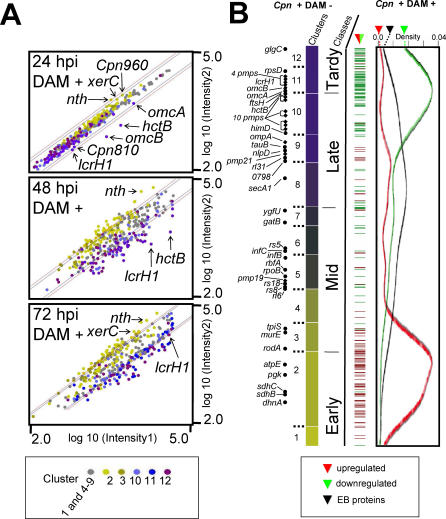
Comparison of Cpn Expression during Persistence with the Cluster and Cluster Class Categorization from the Acute InfectionOnly genes with significant expression changes during both persistent and acute infections are displayed.(A) Intensity blots for 24, 48, and 72 hpi of the persistent infection. Expression values are compared to the corresponding time points of the acute infection. Genes of the persistent infection that can be linked to the acute clusters 2, 3, 10, 11, or 12 are highlighted. Data are displayed as log10 values of the raw intensities. The blue and the red lines indicate a 1.8-fold and a 2.0-fold cutoff, respectively.(B) The 201 significantly and differentially (>±1.8-fold) regulated genes in the persistent infection were compared to their cluster categorization during acute infection (see Figure 1). The bar (DAM +) displays the expression tendency of these genes during persistence, with green for downregulation and red for upregulation, and the position of the gene in the acute cluster categorization from Figure 1. Names of genes mentioned in the text are depicted on the left. For genes upregulated and downregulated during persistence, a Gaussian Kernel Density Estimation representing the positions in the cluster profile is displayed on the right. Gene identification numbers, gene definitions, and gene names can be viewed at http://www.ncbi.nlm.nih.gov.